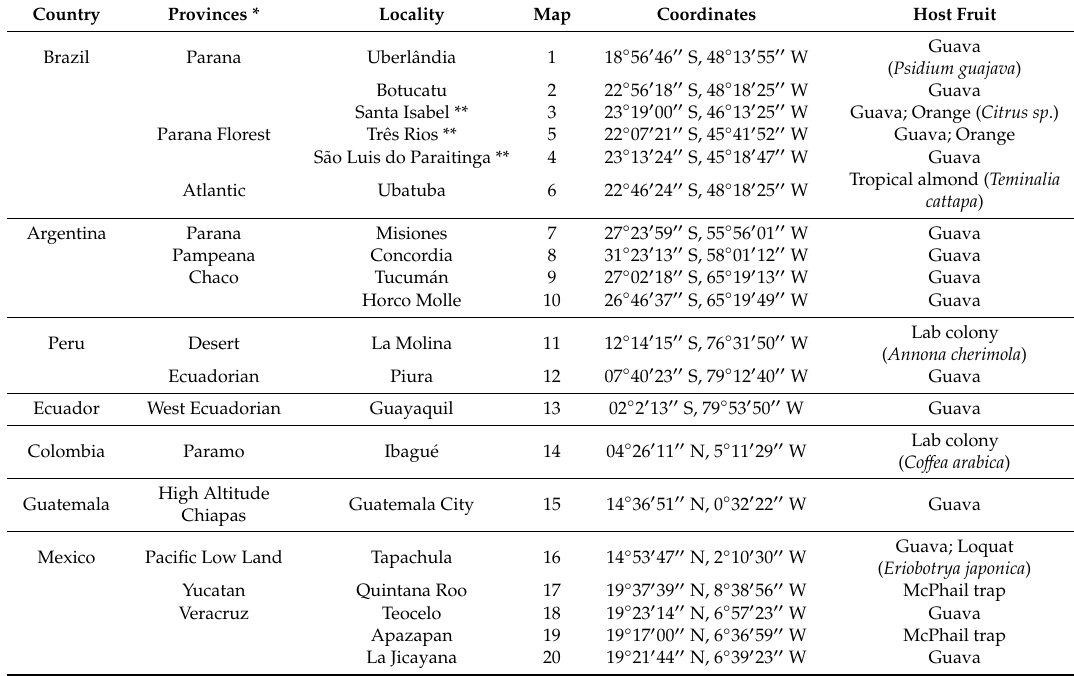
Table 1. Biogeographical variables of AF complex collection